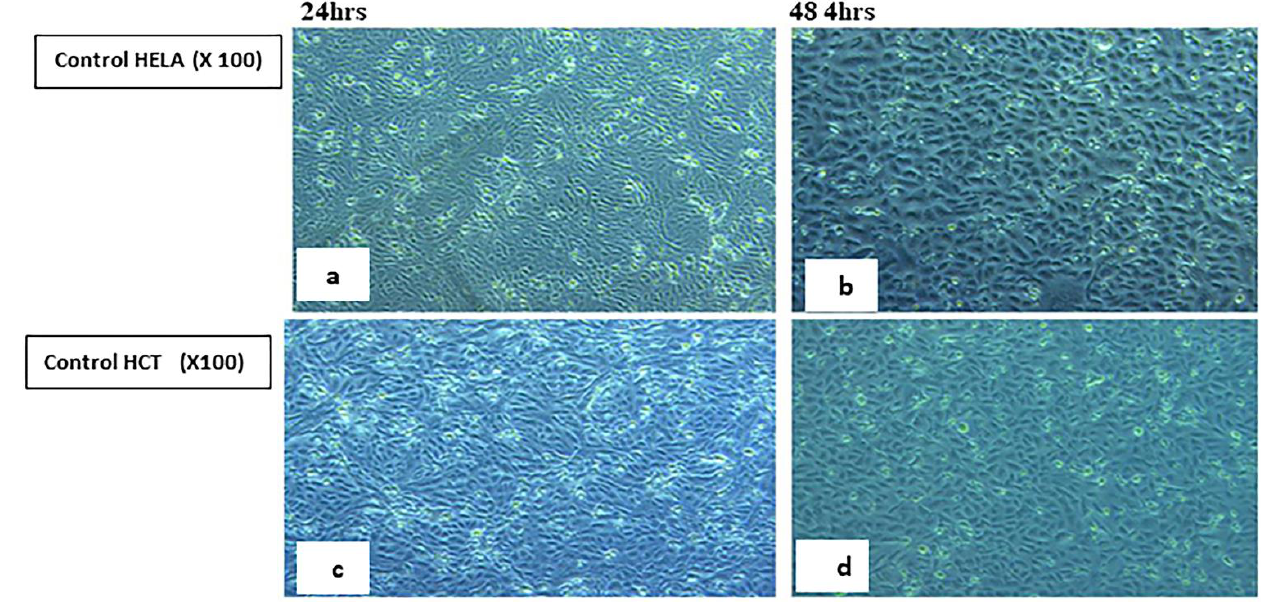
Figure 8. Control (untreated) human HELA and HCT cell lines. Panels ( a , c ) show 90% confluent, spindle shaped adherent cells 24 h after culturing. Panels ( b , d ) show confluent spindle shaped adherent cells, 48 h post-culture. (Phase contrast, X100).